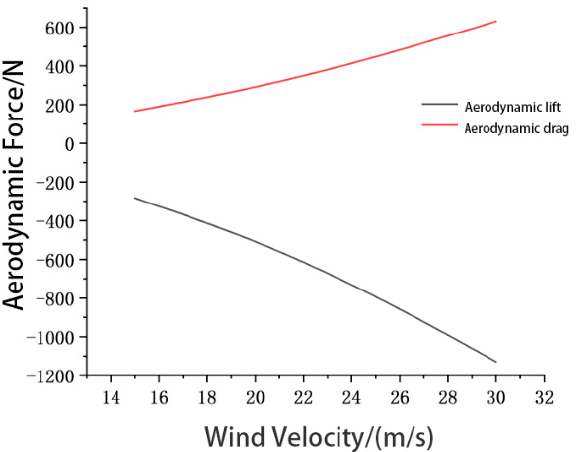
Figure 6. Lifting drag characteristic curve at 15–30 m/s wind velocity in straight-line condition.